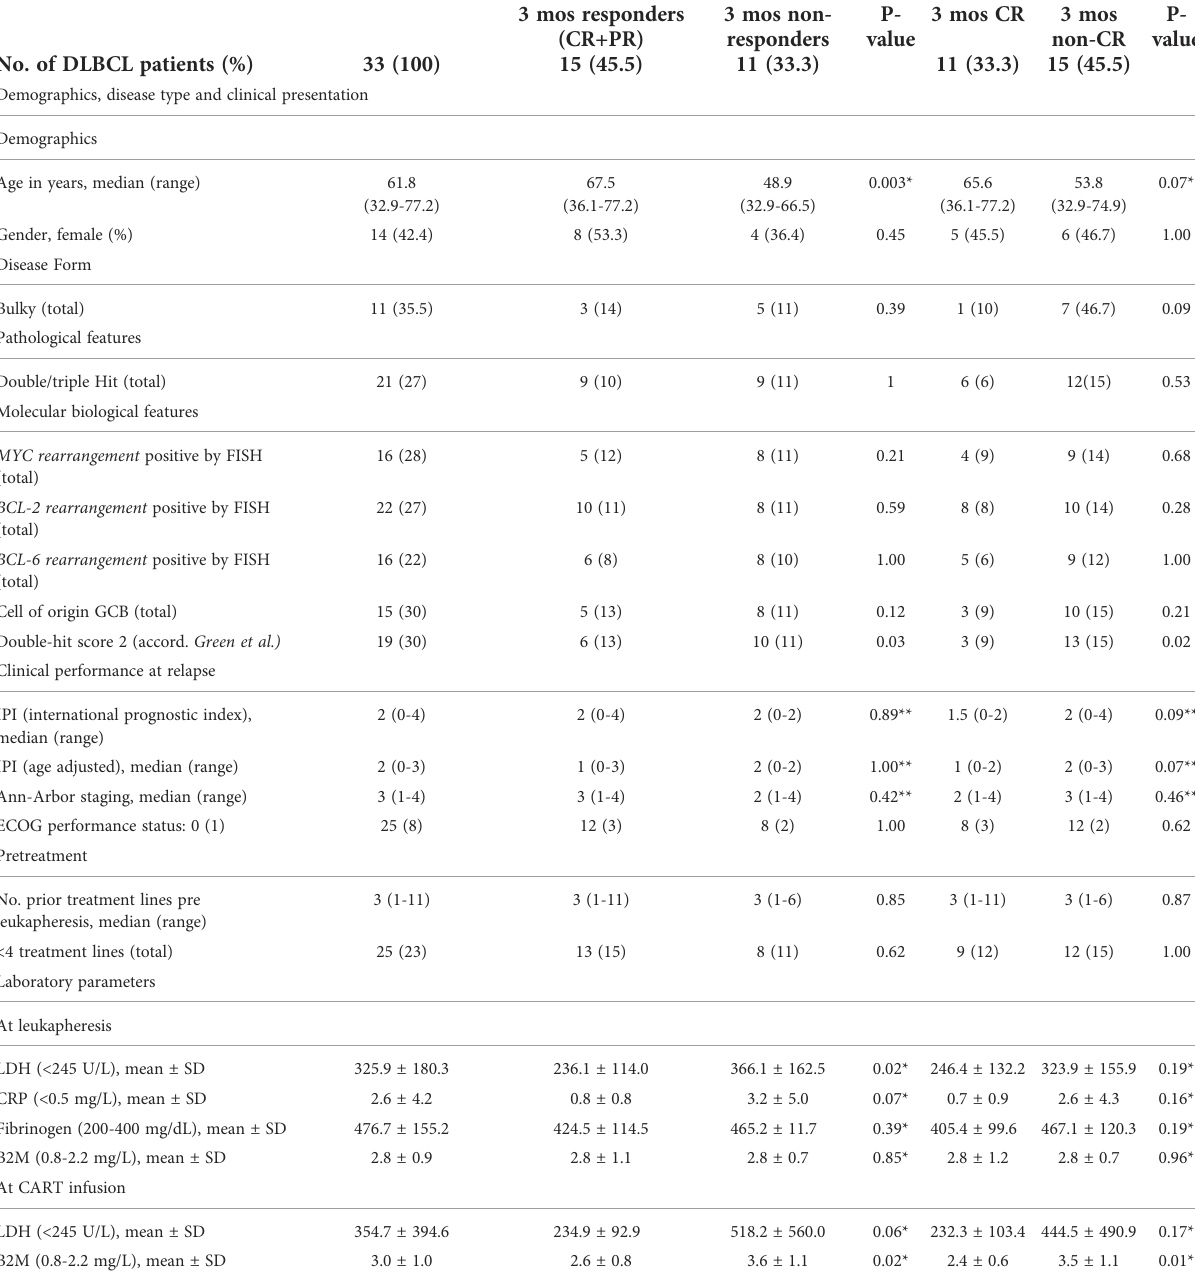
TABLE 1 Demographics, pathological features and clinical performance of